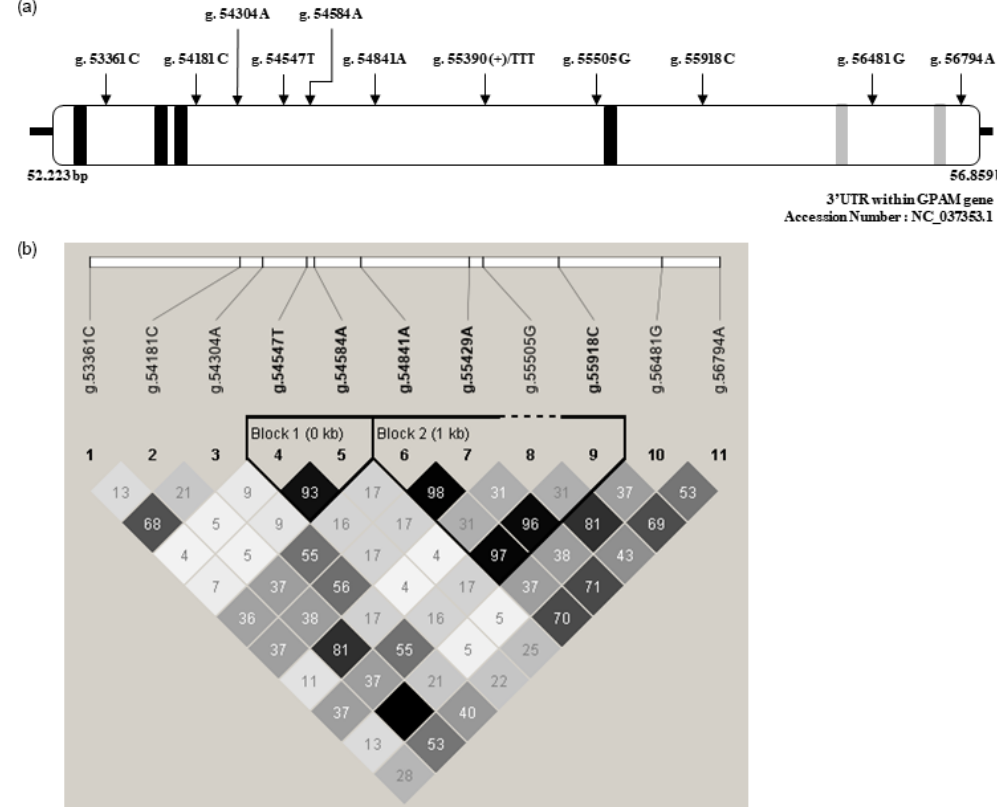
Figure 1. Positions of single-nucleotide polymorphisms (SNPs) in the 3 (cid:48) -UTR of the GPAM gene and their pairwise correlation. (a) SNP position in the 3 (cid:48) -UTR of the GPAM gene. A total of 11 SNPs, 15-LOX-DICE and CPE, which are cis-regulatory elements, were mapped in the 3 (cid:48) -UTR of Korean cattle steer GPAM . 15-LOX-DICE and CPE are represented by black and grey boxes, respectively. (b) Pairwise SNP correlation. The color code on the Haploview plot follows the r 2 color scheme: white ( r 2 = 0); shades of grey (0 <r 2 < 1); black ( r 2 = 1). The numbers in the cells are the r 2 values. However, the r 2 value of 1.0 is not shown (empty cell).